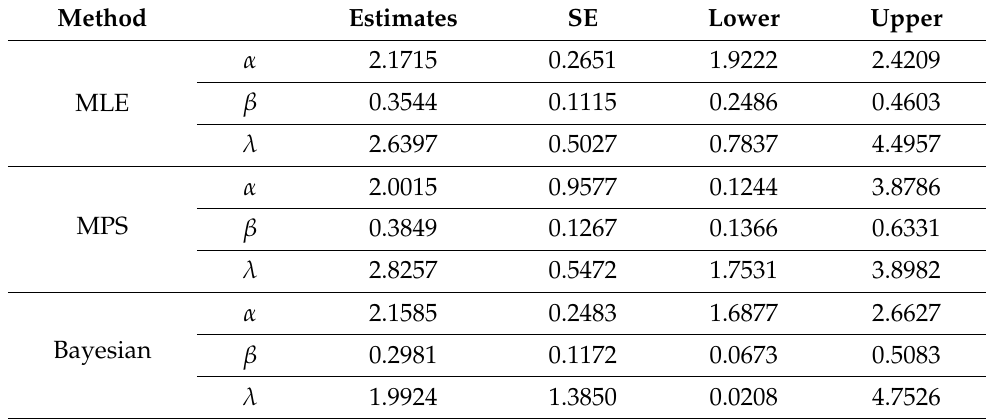
Figure 22. Density plot of posterior MCMC results for parameters of UEPD for the failure of 20 components data. Table 15. M L E , MPS p , Bayesian estimation methods for pandemic coronavirus in France